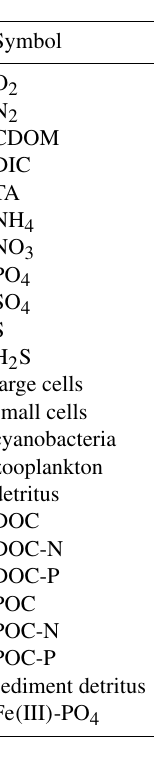
Table B1. State variables of the biogeochemical model